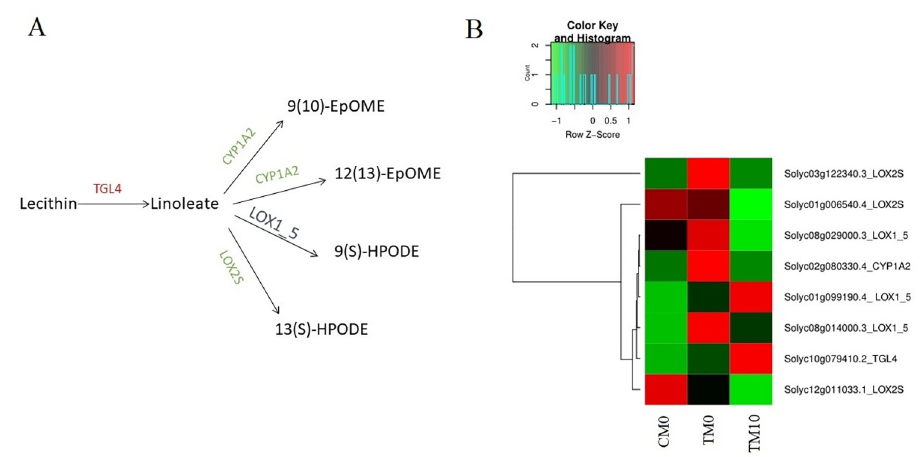
Fig 6. Effects of exogenous melatonin on alpha-linolenic acid metabolism in tomato under drought stress. (A) the alpha-linolenic acid metabolism pathway induced by melatonin in tomato under drought stress (TM10-vs-TM0). The enzymes marked in red and green indicates melatonin-induced up and down regulated genes, respectively. Also, the enzymes marked in dark blue indicates melatonin-induced both up-regulated and down-regulated genes. (B) The expression profiles of the DEGs related to alpha-linolenic acid metabolism in groups of CM0, TM0 and TM10.